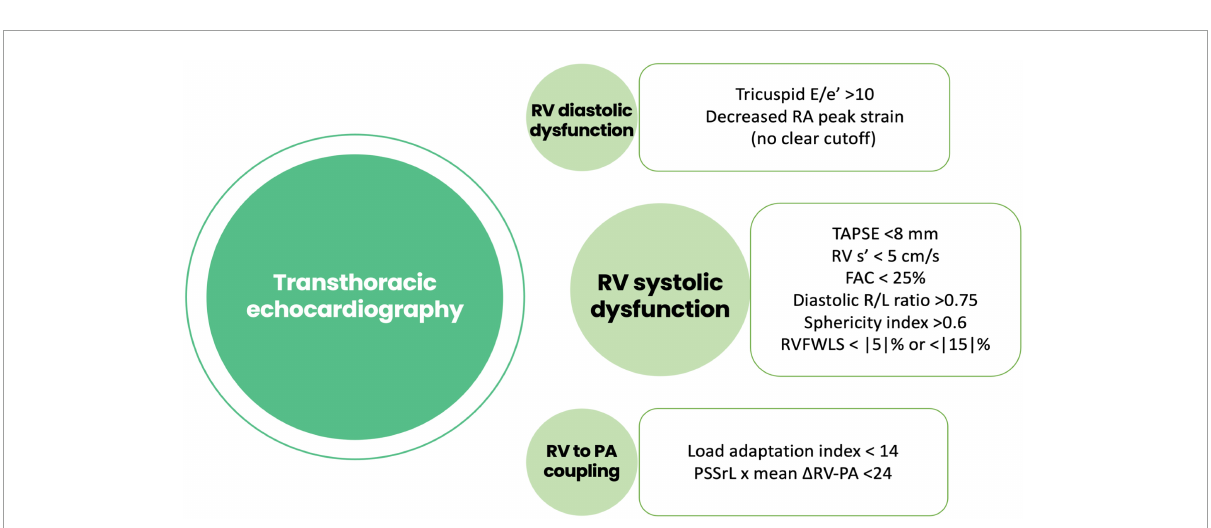
FIGURE3 Risk factors for right ventricular failure after LVAD implantation obtained using echocardiography. RA, right atrial; TAPSE, tricuspid annular plane systolic excursión; RV, right ventricle; FAC, fractional área change; RVFWLS, right ventricular free wall longitudinal strain; PSSrL, peak systolic longitudinal strain rate; PA, pulmonary